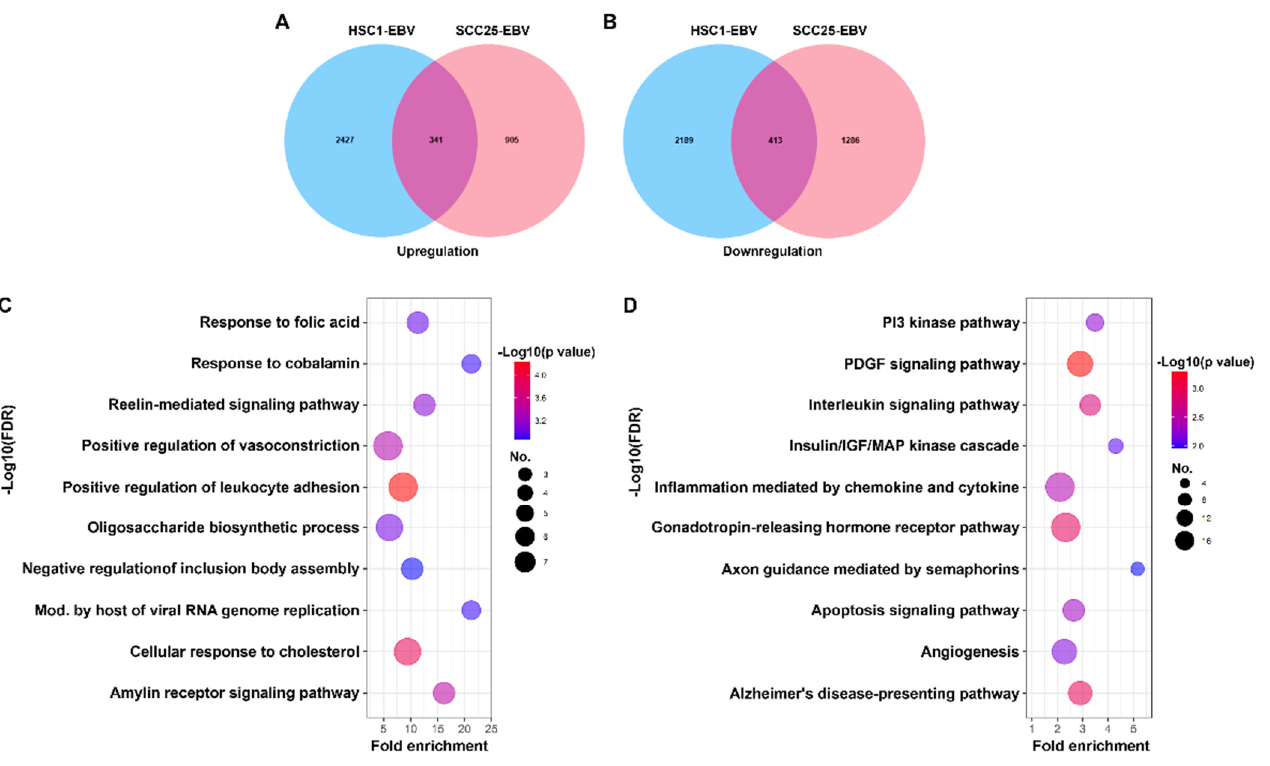
Figure 1. Common DEGs and functional annotation of DEGs in EBVaOSCC. The Venn diagram visualizes the upregulated ( A ) and downregulated ( B ) DEGs in SCC25 ‐ EBV and HSC1 ‐ EBV cells. Bubble diagram of functional enrichment analysis for DEGs. The top 10 enrichment results of the biological process ( C ) and KEGG pathway ( D ) are presented in a bubble diagram. The Y ‐ axis on the left indicates the top 10 functional enrichment results. The X ‐ axis indicates the percentage of genes involved in the biological process and the KEGG pathway. The color represents the p ‐ value, and a range from red to blue indicates a low to high p ‐ value, respectively. The size of the bubble indicates the gene numbers involved in the biological process and KEGG pathway.